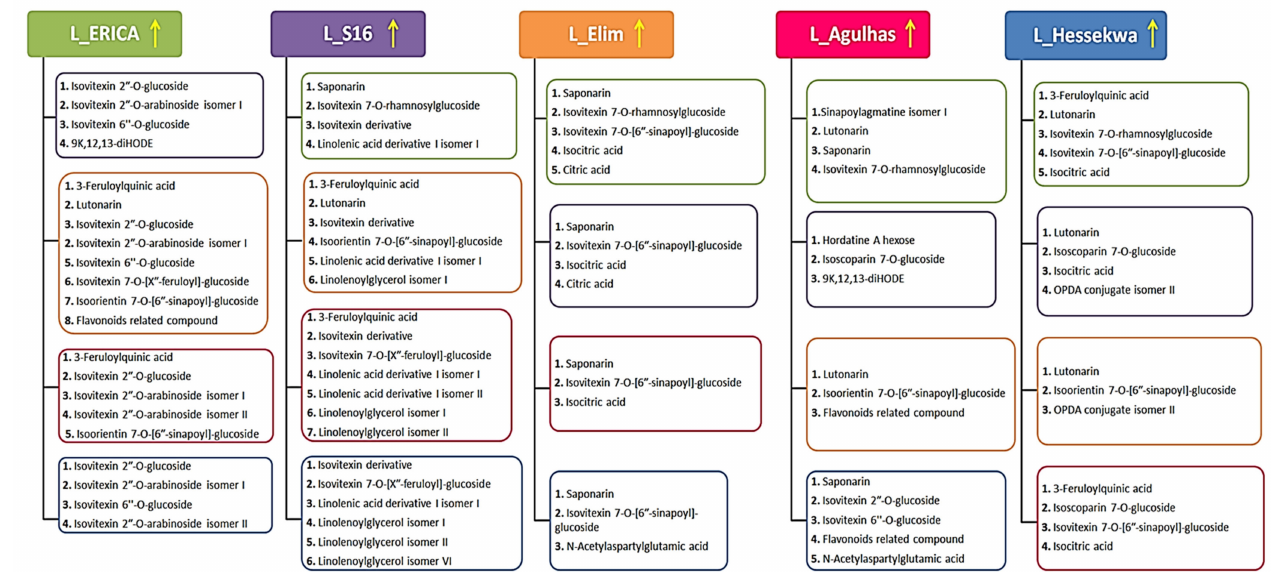
Figure 7. Discriminant metabolites selected from OPLS-DA loadings S-plots generated from the comparison of extracts from leaves from the five cultivars with each other. The arrow indicates the positive correlation of the four groups of metabolites with the corresponding cultivars, e.g., in the first column, comparing ‘Erica’ to ‘S16’, all metabolites in the dark purple rectangle (corresponding to ‘S16’) are positively correlated with ‘Erica’ and negatively correlated with ‘S16’. Using the example in Figure 6 comparing ‘Erica’ and ‘Elim’, eight metabolites were found to be positively correlated to the former, and five were positively correlated to the